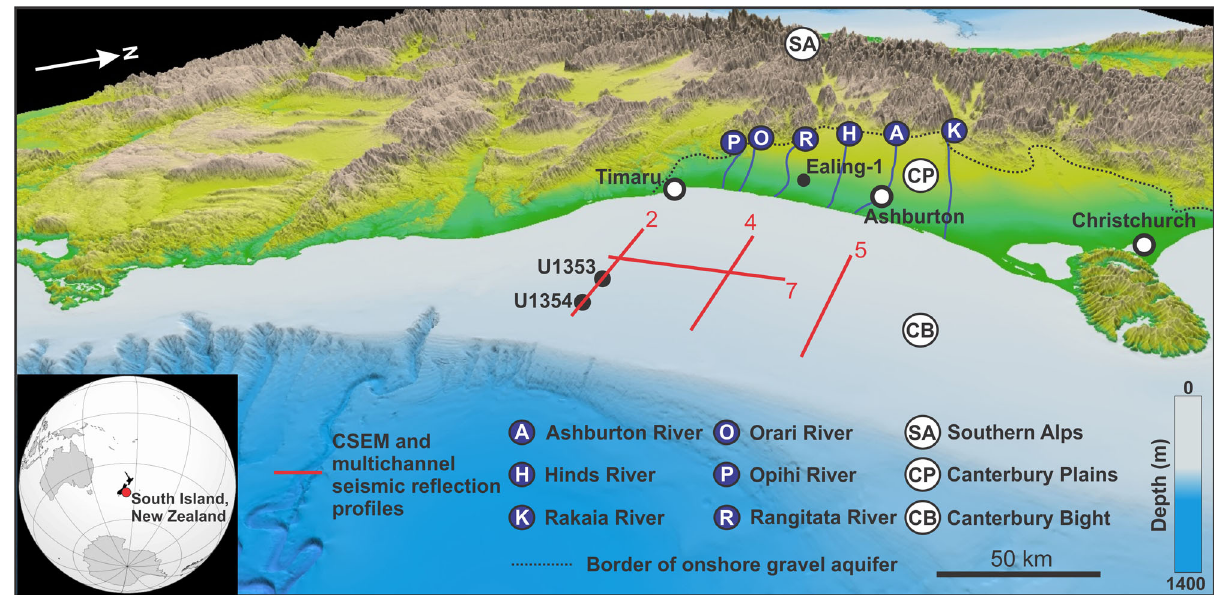
Fig. 1 Study area. Three-dimensional digital elevation model of the Canterbury Basin (Source: https://data/linz.govt.nz). The location of the rivers, onshore gravel aquifer, onshore well Ealing-1, CSEM and multichannel seismic re fl ection lines, and boreholes U1353 and U1354, is